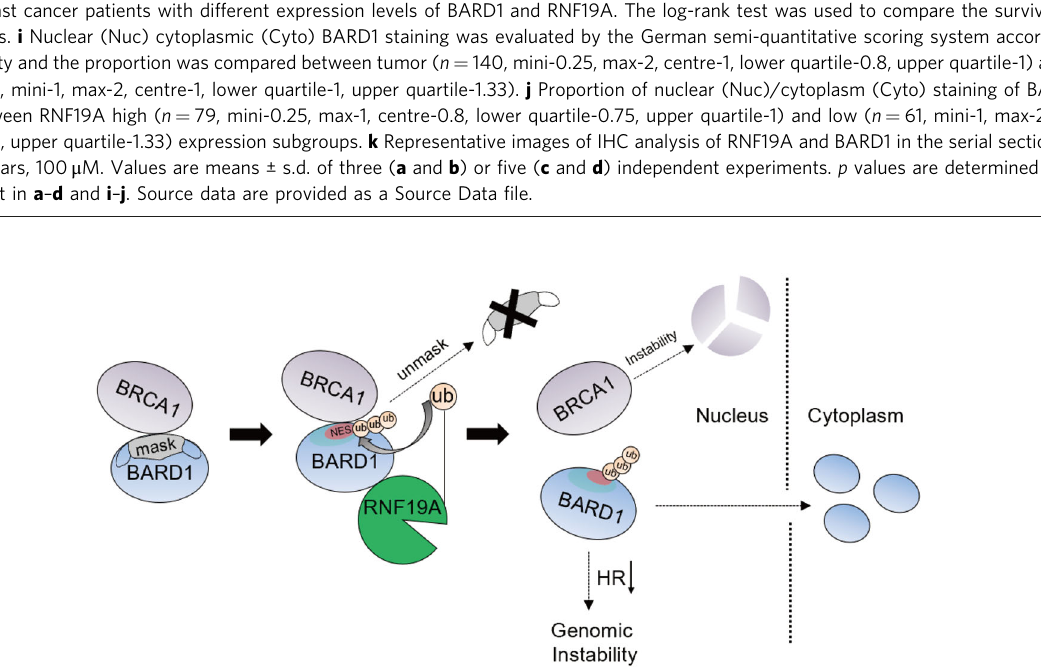
Fig. 7 Schematic model of BARD1 regulation by RNF19A. RNF19A interacts with BARD1 and promotes its ubiquitination. The ubiquitination of BARD1 unveils the NES of BARD1 located within its RING domain, resulting in the dissociation of BRCA1/BARD1 complex and the export of BARD1 to the